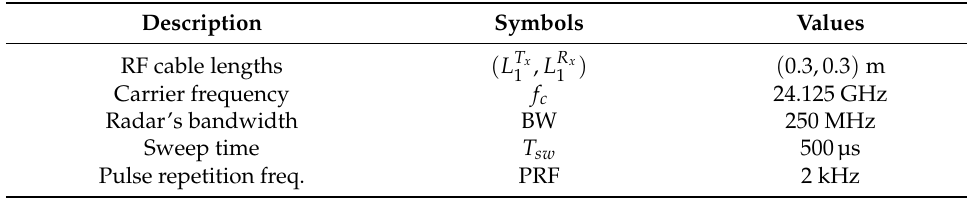
Table 1. System parameters of the SISO experimental setup. Description Symbols Values ) ( 0.3,0.3 ) m RF cable lengths ( L T x , L R x 1 1 Carrier frequency f c 24.125 GHz Radar’s bandwidth BW 250 MHz Sweep time T sw 500µs Pulse repetition freq. PRF 2